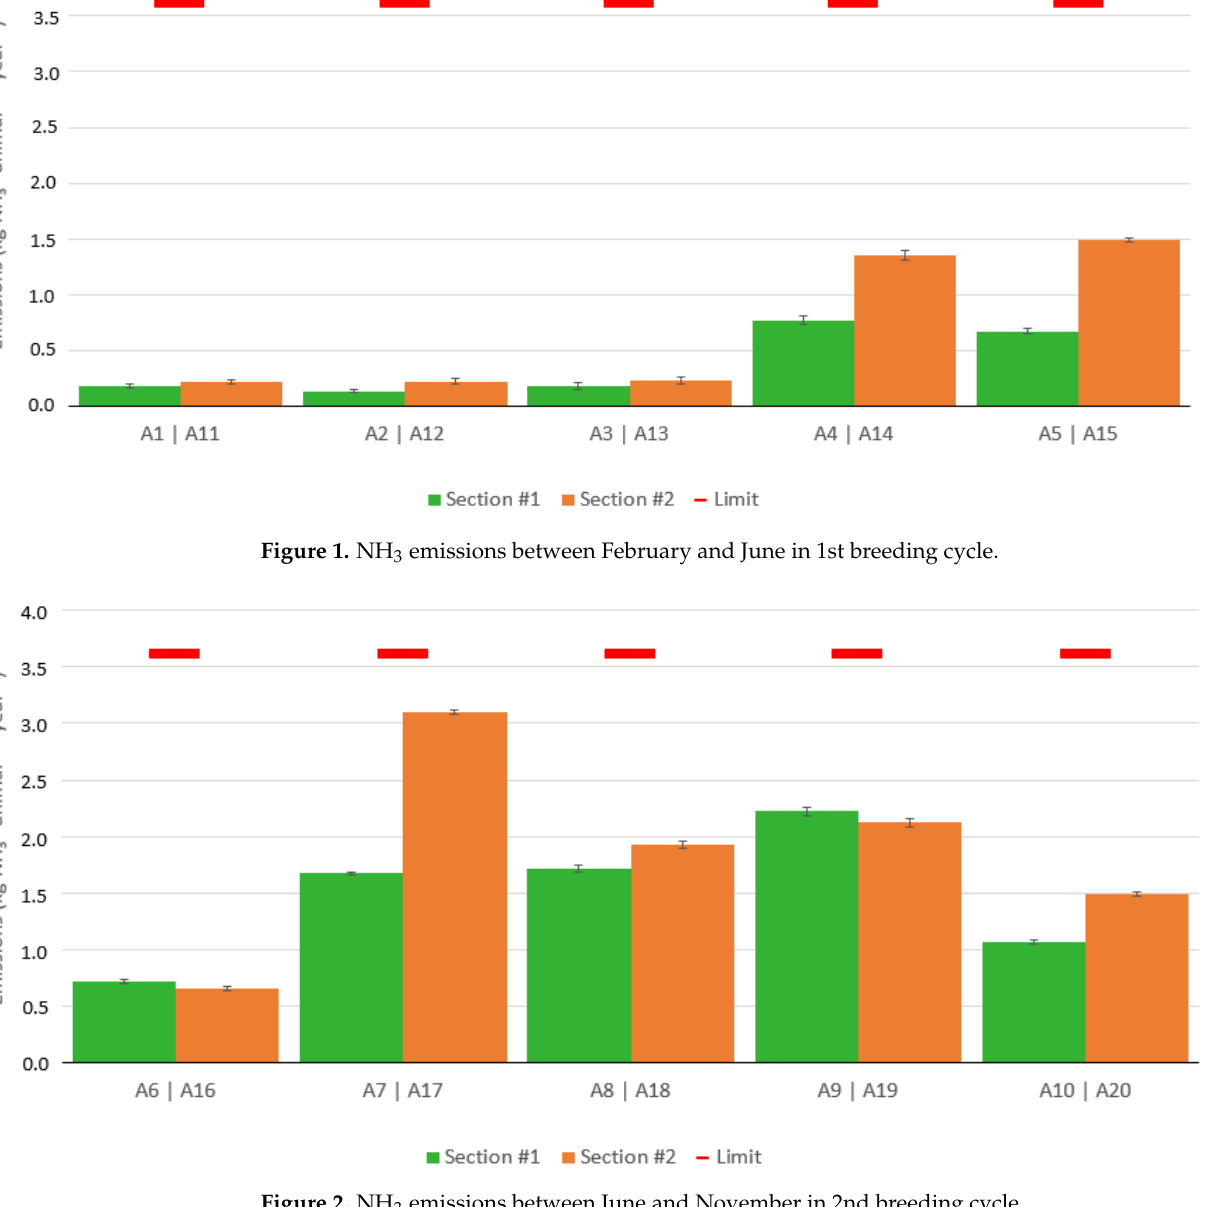
Figure 2. NH 3 emissions between June and November in 2nd breeding cycle.